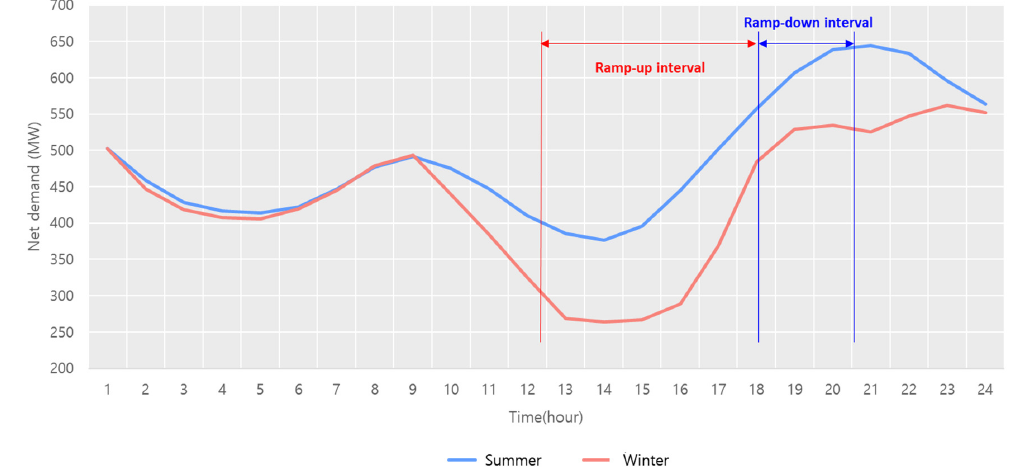
/ down interval based on the net-demand profile of summer and Figure 1. Ramp-up/down interval based on the net-demand profile of summer and winter. Figure 1. Ramp-up